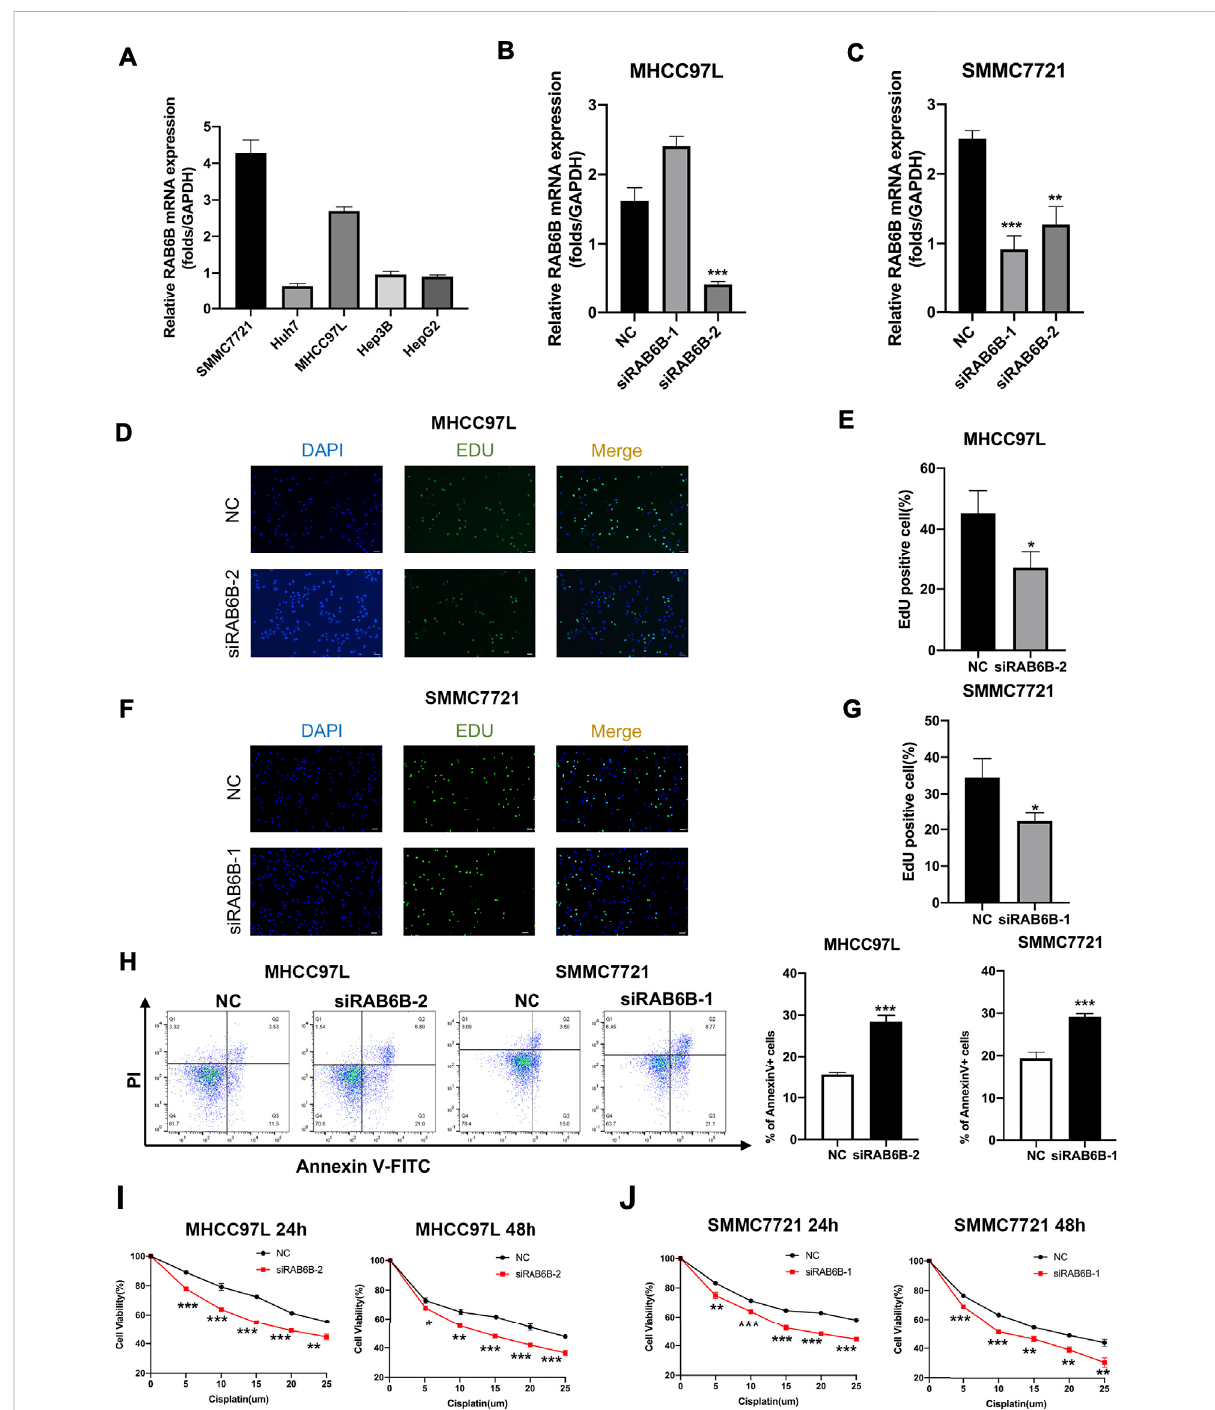
FIGURE 9 Effects of RAB6B knockdown on cell proliferation, apoptosis, and drug sensitivity in HCC cells. (A) The qRT-PCR result showed the RAB6B mRNAExpression invariousHCCcell lines. (B) TheqRT-PCRresult showedtheknockdown ef fi ciency ofRAB6Bafter transfection ofMHCC97L cells with two different siRNAs. (C) Knockdown ef fi ciency of RAB6B after transfection of SMMC7721 cells with two different siRNAs. (D,E) The effect of RAB6Bknockdownoncellproliferation inMHCC97LcellswasperformedbyEdUassay.Scalebar,20um. (F,G) TheeffectofRAB6Bknockdown on cell proliferation in SMMC7721 cells was performed by EdU assay. Scale bar, 20 µm. (H) The effect of RAB6B knockdown on cell apoptosis in MHCC97L and SMMC7721 cells performed by fl ow cytometry. (I,J) Gradient doses of cisplatin were used to treat MHCC97L cells (I) or SMMC7721 cells (J) for 24 and 48 h, and the cell viability was measured by MTT assay. All above data were presented as the mean ± SD, n = 3. NC, negative control. * p < 0.05; ** p < 0.01; *** p <